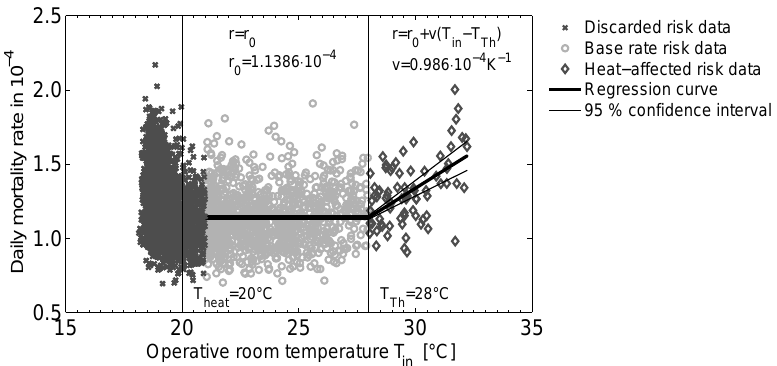
Figure 6. Mortality rate of Berlin citizens aged 65 and older in relation to operative room temperature from the EnergyPlus model and linearized risk–hazard curve according to Eq. (16) for a threshold temperature of 28 ◦